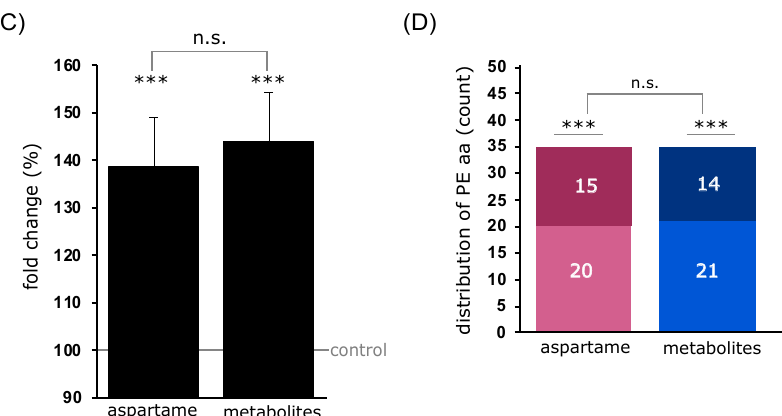
Figure 6. Effects of aspartame or aspartame metabolites on phosphatidylethanolamine (PEaa) species. Neuroblastoma cells (SH-SY5Y) were treated as described before with control, aspartame, or aspartame metabolites for 48 h and analyzed using a semi-quantitative shotgun lipidomics approach. Each diagram represents the changes in the aspartame- or metabolite-treated cells in comparison to control-treated cells. ( A ) In the volcano plot, each PEaa species is graphically represented by a pink (aspartame treatment) or blue (aspartame metabolite treatment) dot which is plotted with its fold change ( x -axis) against its according p -value ( y -axis). The volcano plot is structured as the one in Figure 4. ( B ) Venn diagram of Peaa species after incubation of SH-SY5Y cells with aspartame or aspartame metabolites. Alterations of the same species are visible in the overlapping part. ( C ) The bar chart shows the relative fold change of all measured Peaa species after aspartame treatment compared to treatment with aspartame metabolites. Error bars represent the standard error of the mean (SEM), and the statistical significance was set as *** p ≤ 0.001. ( D ) Distribution of PEaa species, classified by the amount of increased or decreased PEaa species. The bar chart is structured as the one in Figure 4. The applied statistical analyses are described in detail in Section 2.9 (n.s. not significant).